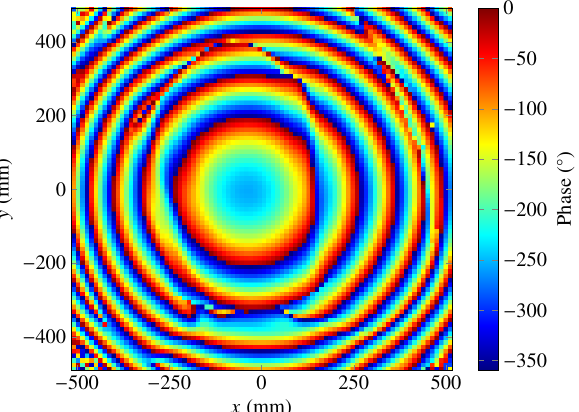
Figure 5. Phase distribution obtained with a phase-only synthesis algorithm to achieve a European contoured-beam copolar pattern. Table 1. Performance of the proposed database with regard to SVR and MoM-LP tools for layout design. Tool Time (s) Speed-Up MoM-LP 1572.55 1 SVR Database 0.04 39,314